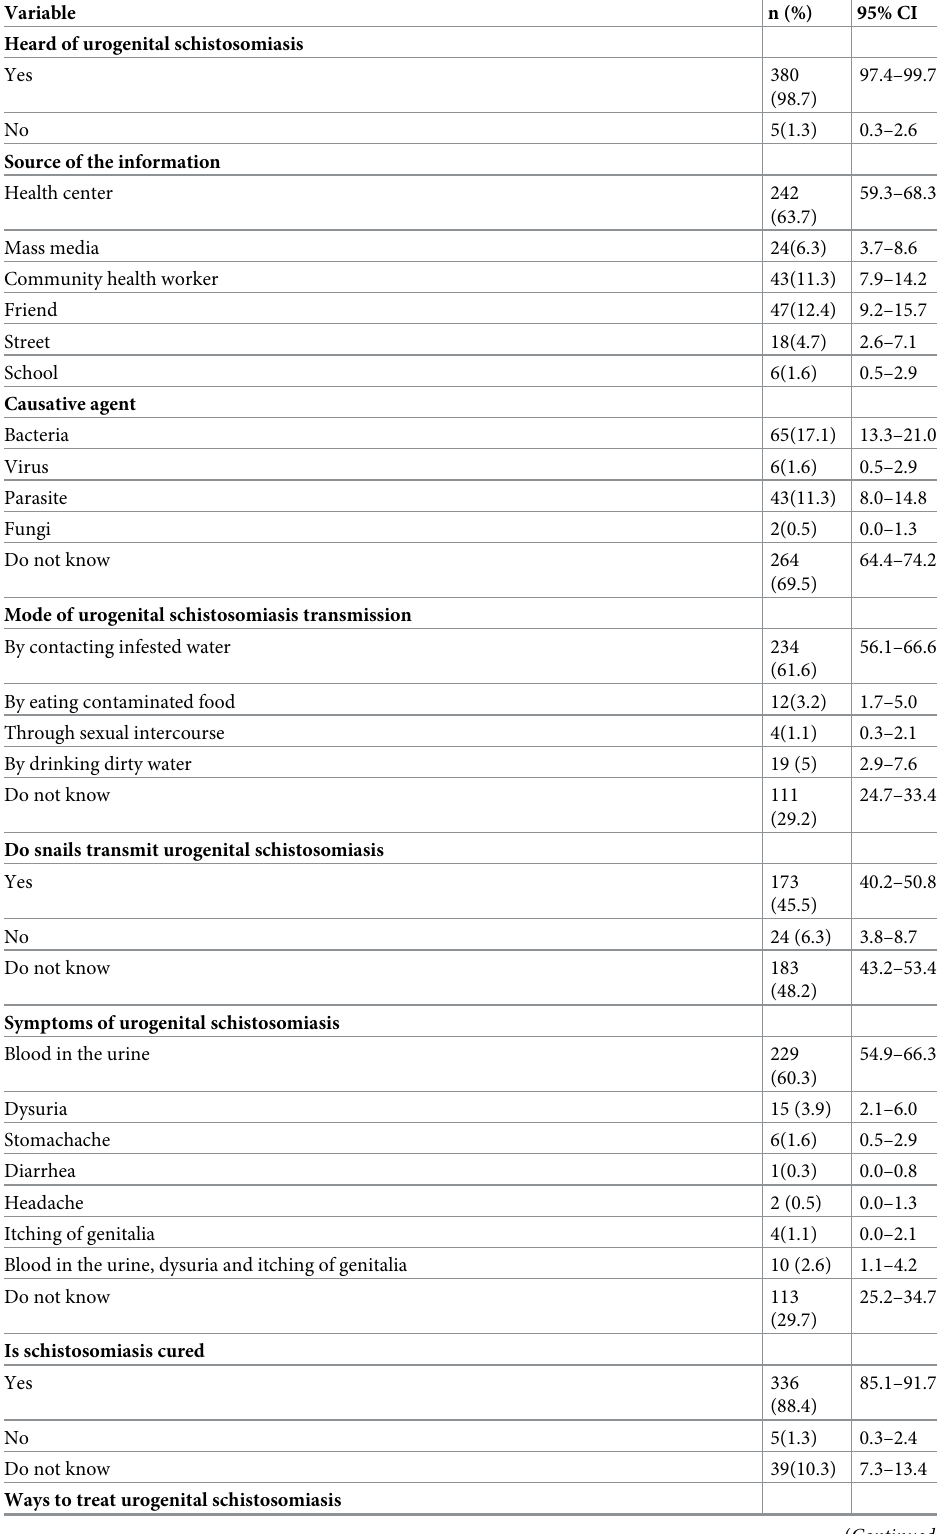
Table 3. Knowledge on urogenital schistosomiasis among the parents/guardians of the under-fives (n =